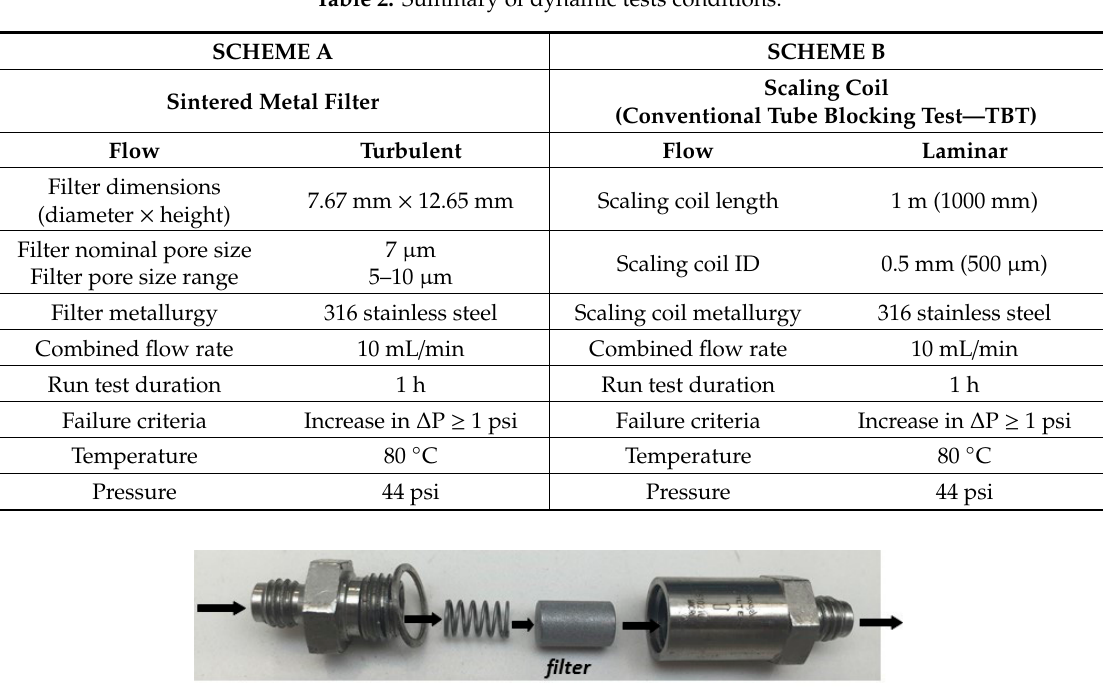
Figure 3. Schematic of turbulent flow in the dynamic system using a 316 stainless steel filter. Table 2. Summary of dynamic tests conditions.